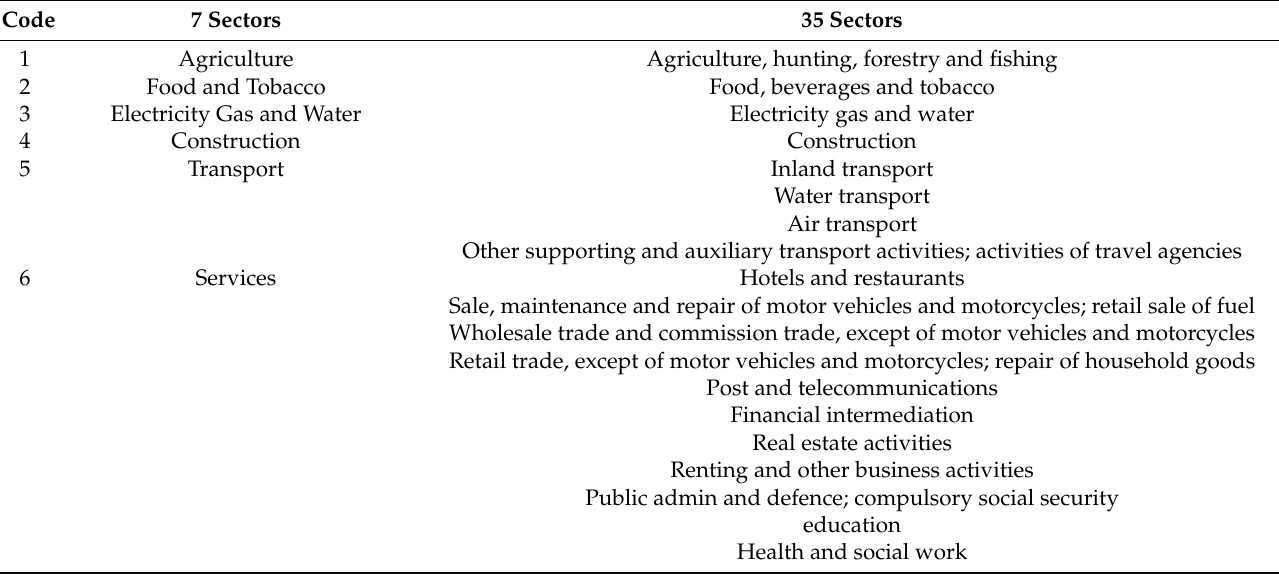
Table A1. 35 sectors aggregated into 7